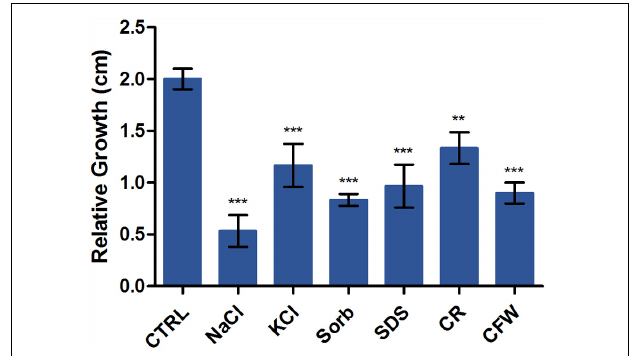
FIGURE 2 | Susceptibility of T. rubrum to various stressors. Strains were inoculated on Sabouraud dextrose broth with or without the stressors NaCl, KCl, sorbitol (Sorb), SDS, Congo Red (CR), and Calcofluor White (CFW) at 28 ◦ C for 6 d. The graph represents the relative colony diameters (in centimeters) of each strain in the presence of the stressors relative to the control (CTRL), without the stressors. Data are means of three biological replicates. The error bar indicates the standard deviation (SD). Asterisks indicate statistical significance determined by ANOVA followed by Tukey’s ad hoc test ( ∗∗ P < 0.01; ∗∗∗ P <